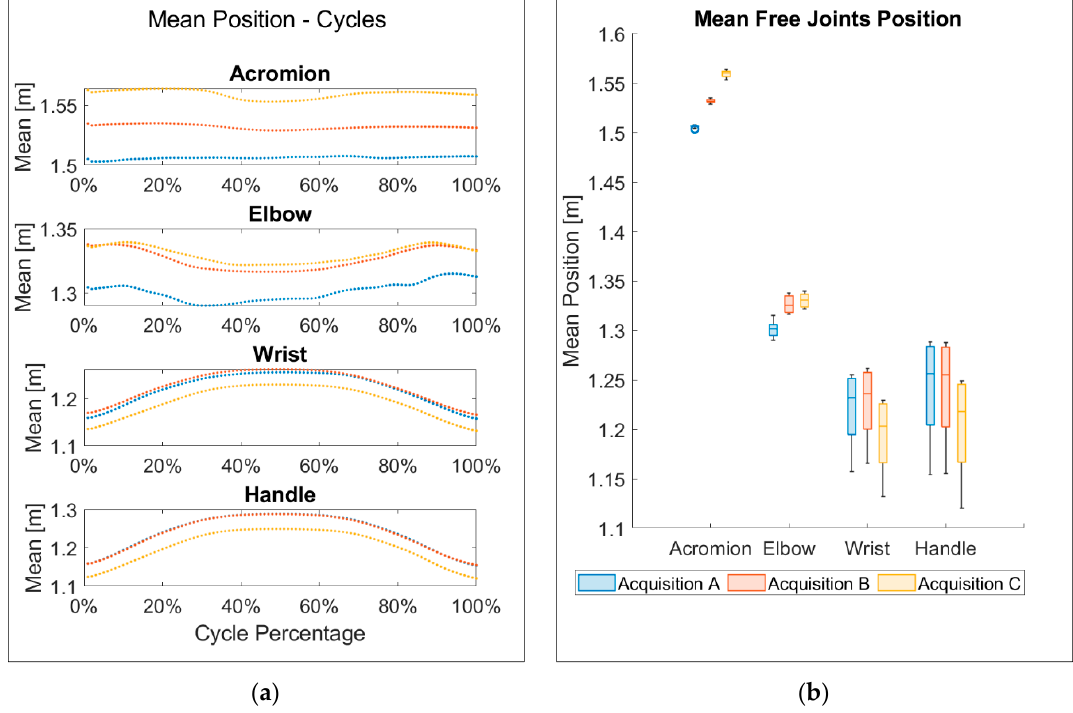
Figure 6. From the left, ( a ) mean position of the joints of the reduced kinematic model, with respect to the cycle percentage, and ( b ) boxplot comparison of the same mean signals. Colors refers to the three analyzed acquisitions: blue for A, red for B, and yellow for C.